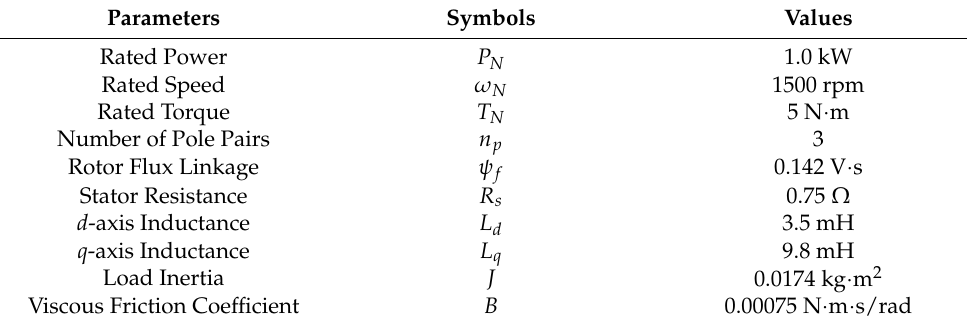
Table 3. IPMSM parameters.